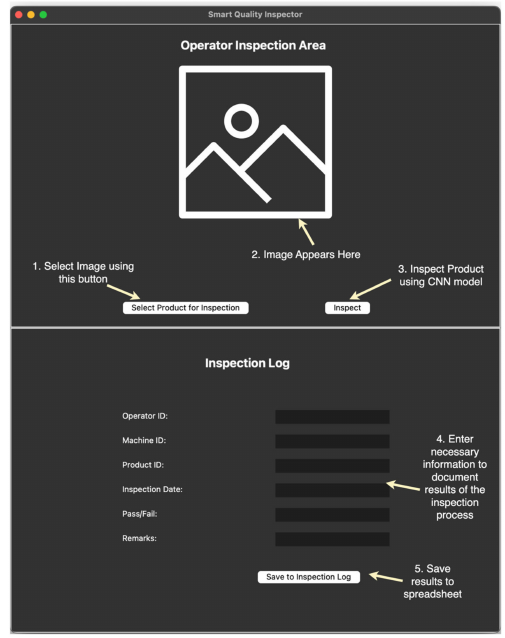
Figure 6. Shop floor application for Smart Quality